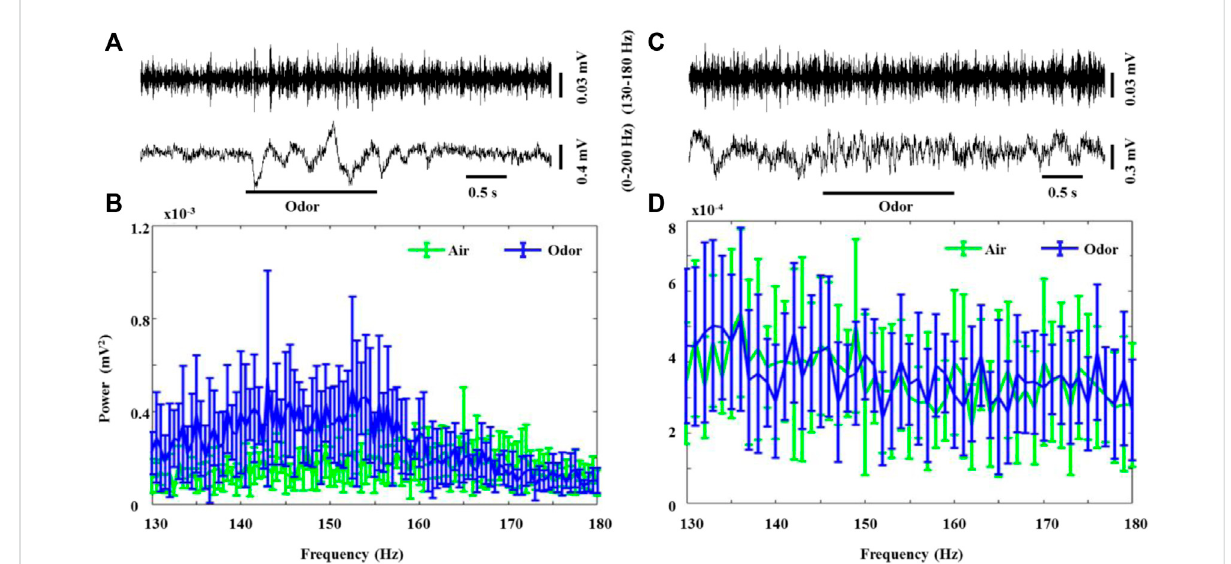
FIGURE 3 Odor-evoked high-frequency oscillations (130 – 180 Hz) responses in the OB of awake and anesthetized rats. (A) Typical OB 0 – 200 Hz activity and HFO traces from an awake rat under nonanoic acid (NA) stimulation. Shown are the HFO activity and 0 – 200 Hz activity. The mean fast Fourier transform (FFT) power spectrum showing the distribution of energy from HFO-bands (B) across three awake rats under air (green line) and NA (blue line) stimulation. The trial-averaged data are presented as the mean ± SEM, n = 12, 4 trials per rat. (C) Typical OB 0 – 200 Hz activity and HFO traces from an anesthetized rat under nonanoic acid (NA) stimulation. Shown are the HFO activity and 0 – 200 Hz activity. The mean fast Fourier transform(FFT)powerspectrumshowingthedistribution ofenergyfromHFO-bands (B) acrossthethreeanesthetized ratsunderair(green line)and NA(blueline)stimulation.Thetrial-averageddataarepresentedasthemean±SEM, n =12,4trialsperrat.Theshortblacklinerepresentstheduration of 0.5s, and the long black line represents the duration of the odor